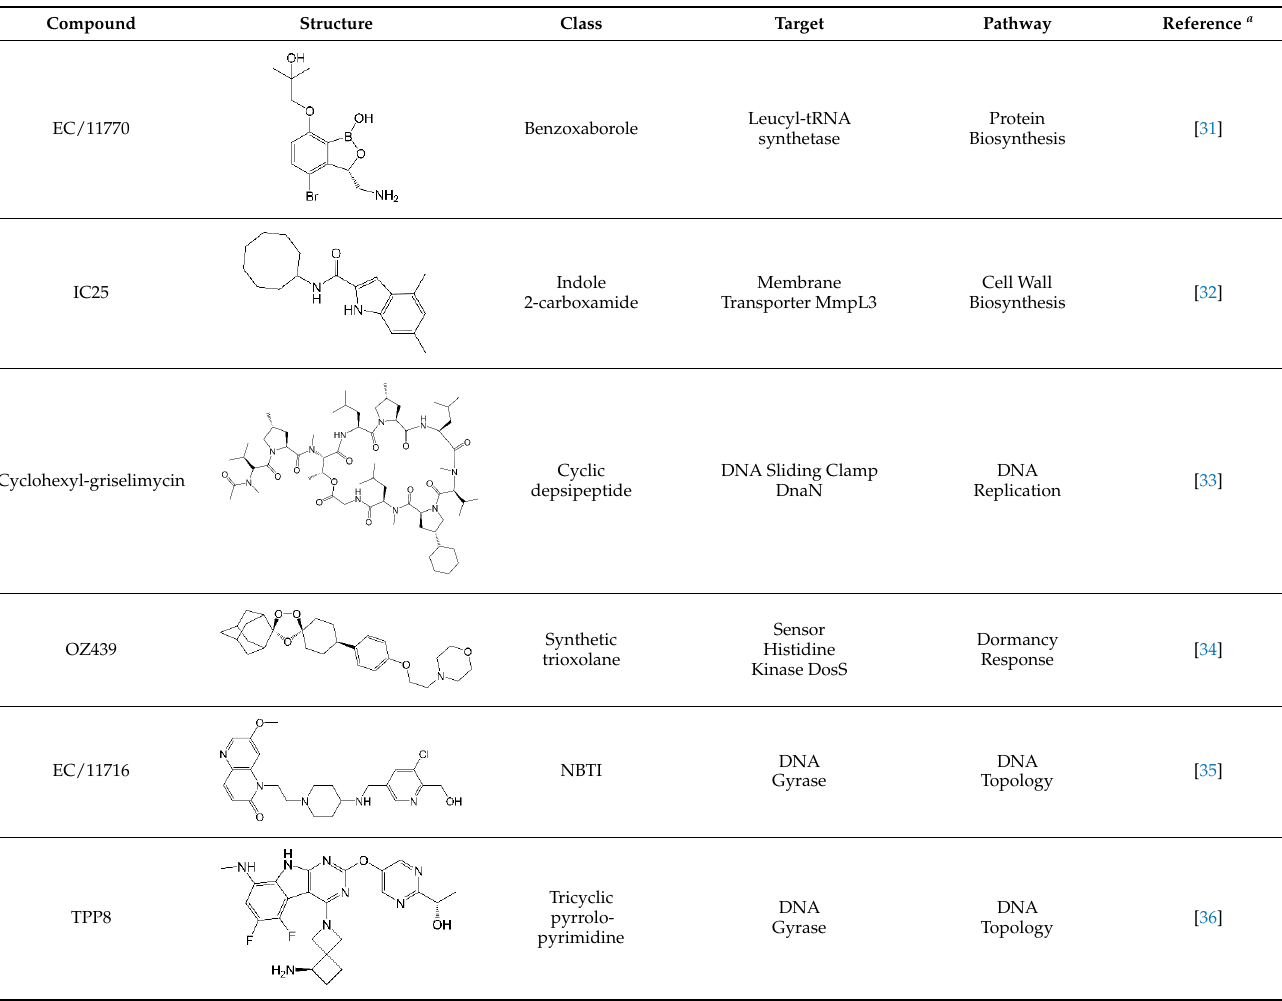
Table 1. TB active compounds identified as advanced lead compounds for M. abscessus lung disease. Compound